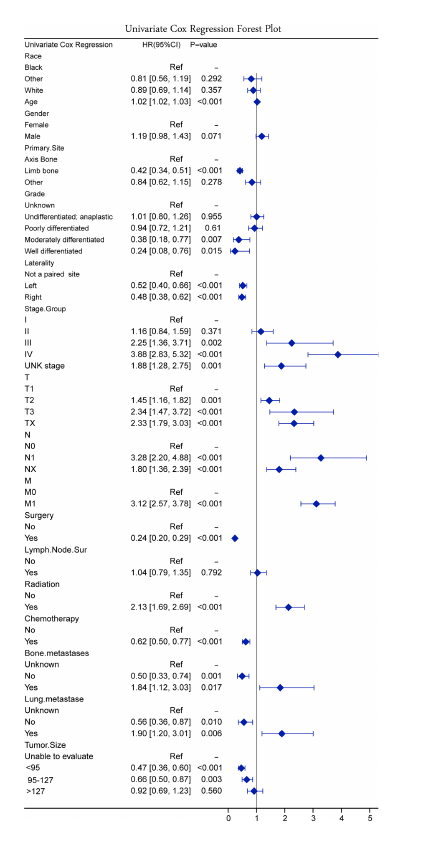
FIGURE 3 Forest plot on univariate Cox